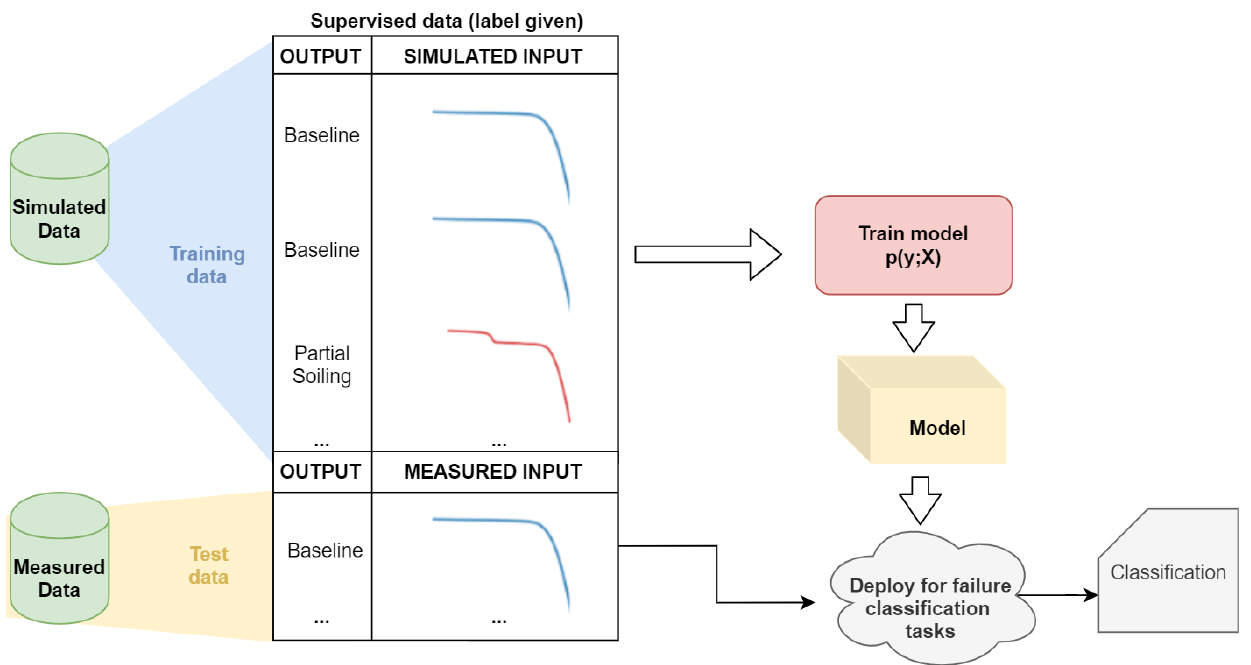
Figure 2. A failure classification pipeline is postulated where simulated data is utilized for training a model. With this trained model, measured curves can be classified in a production setting. Using simulated data allows the augmentation of data representing rare failures, which are not often present in measured